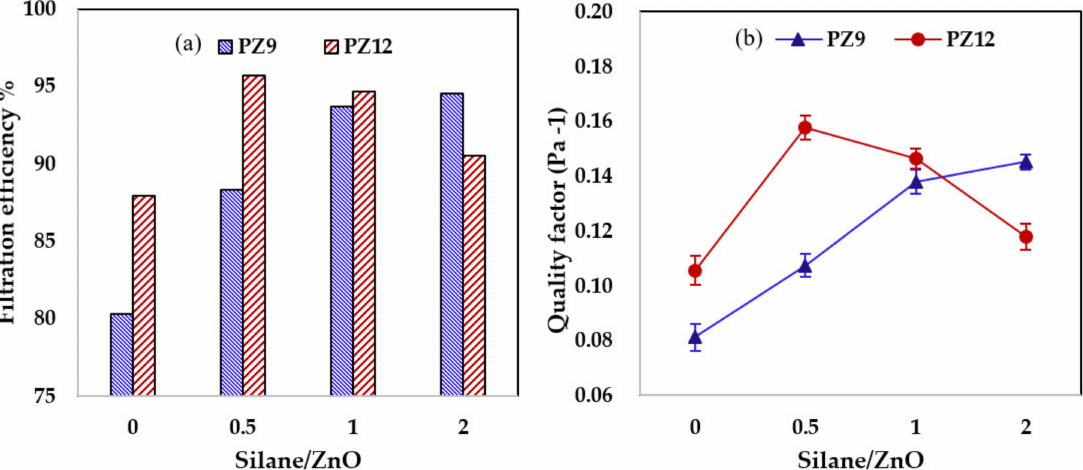
Figure 7. Filtration performance of various nanofiber filters for 300 nm KCl particles under a constant pressure drop of 20 Pa; ( a ) filtration efficiency and ( b ) quality